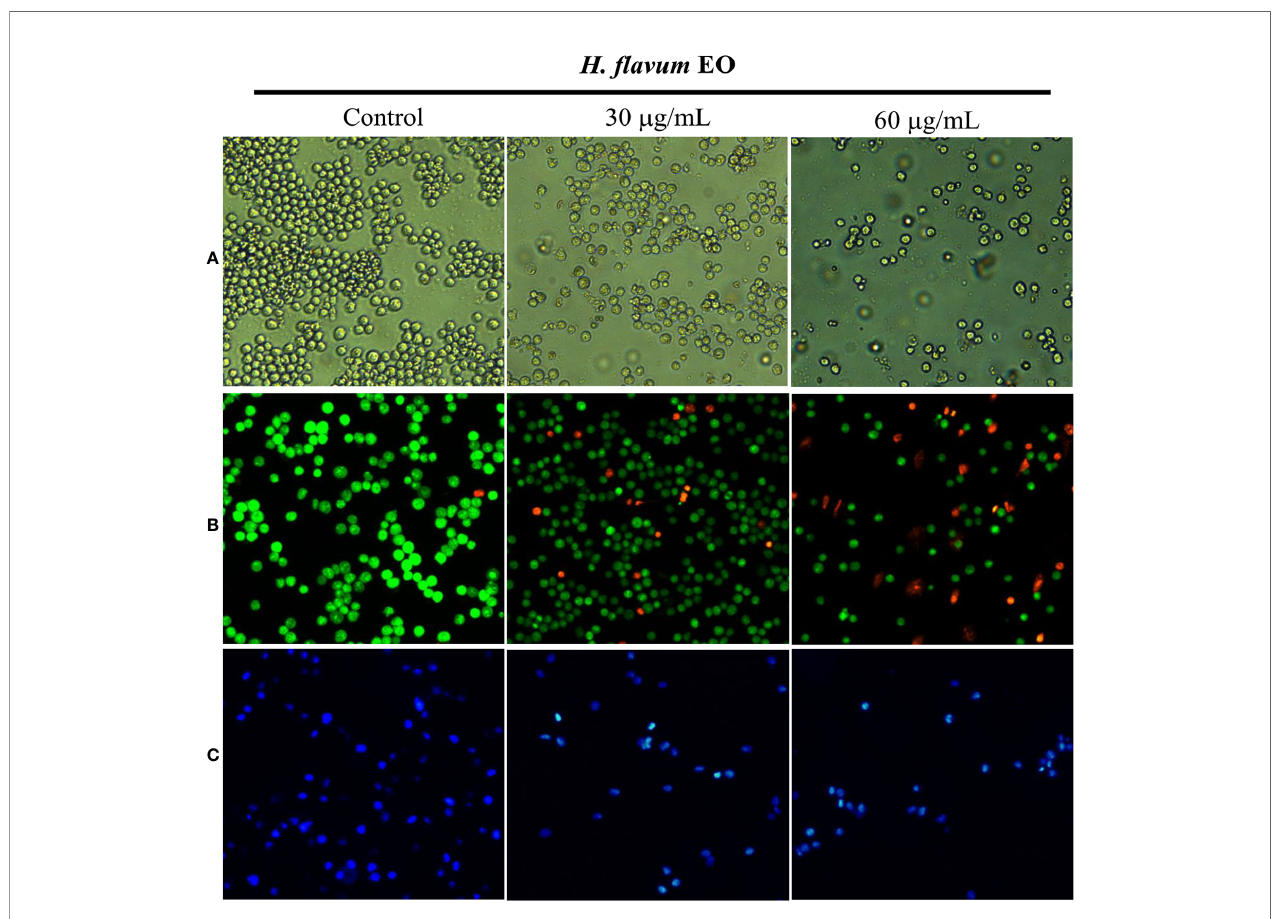
FIGURE 4 | Effect of H. fl avum EO on the morphology of K562 cells. (A) The cells were treated with EO (0, 30, 60 m g/mL) and the morphological changes of the cells were observed using an inverted microscope (100×). The cells were treated as described above and then stained with AO/EB (B) and Hoechst 33258 (C) . The morphological changes were observed using a fl uorescence microscope (100×).